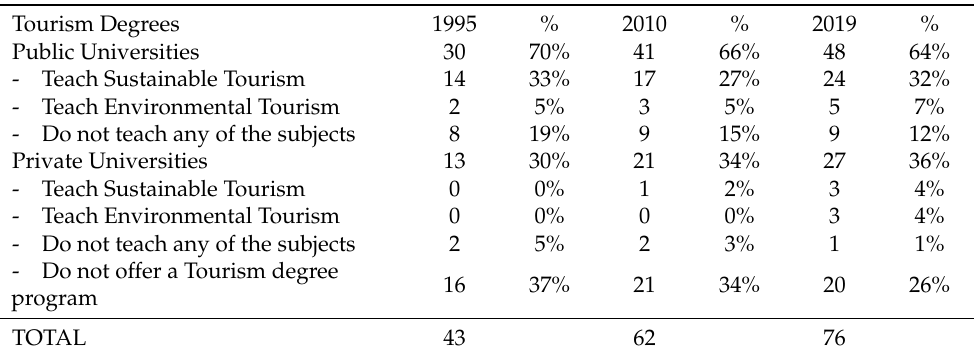
Table 1. Sustainability related subjects in Spanish under-graduate Tourism degree